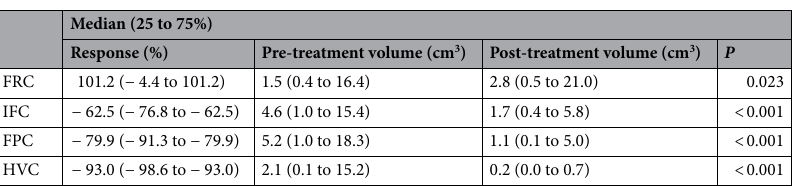
Table 4. Pre- and post-treatment volumes of angiomyolipoma compartments and percent responses to treatment with sirolimus. Comparisons between pre- and post-treatment volumes were performed with the Wilcoxon signed rank test. FPC fat-poor compartment, FRC fat-rich compartment, HVC highly-vascularized compartment, IFC intermediate-fat